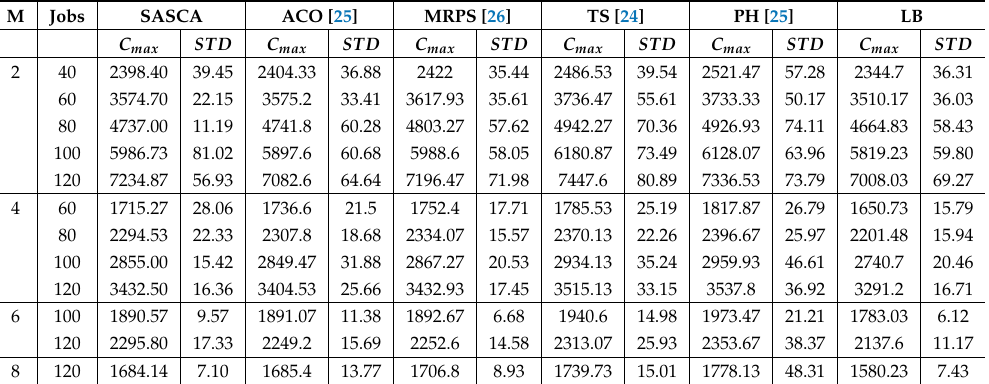
Table 7. Average of C max values of the large problems for each algorithm.